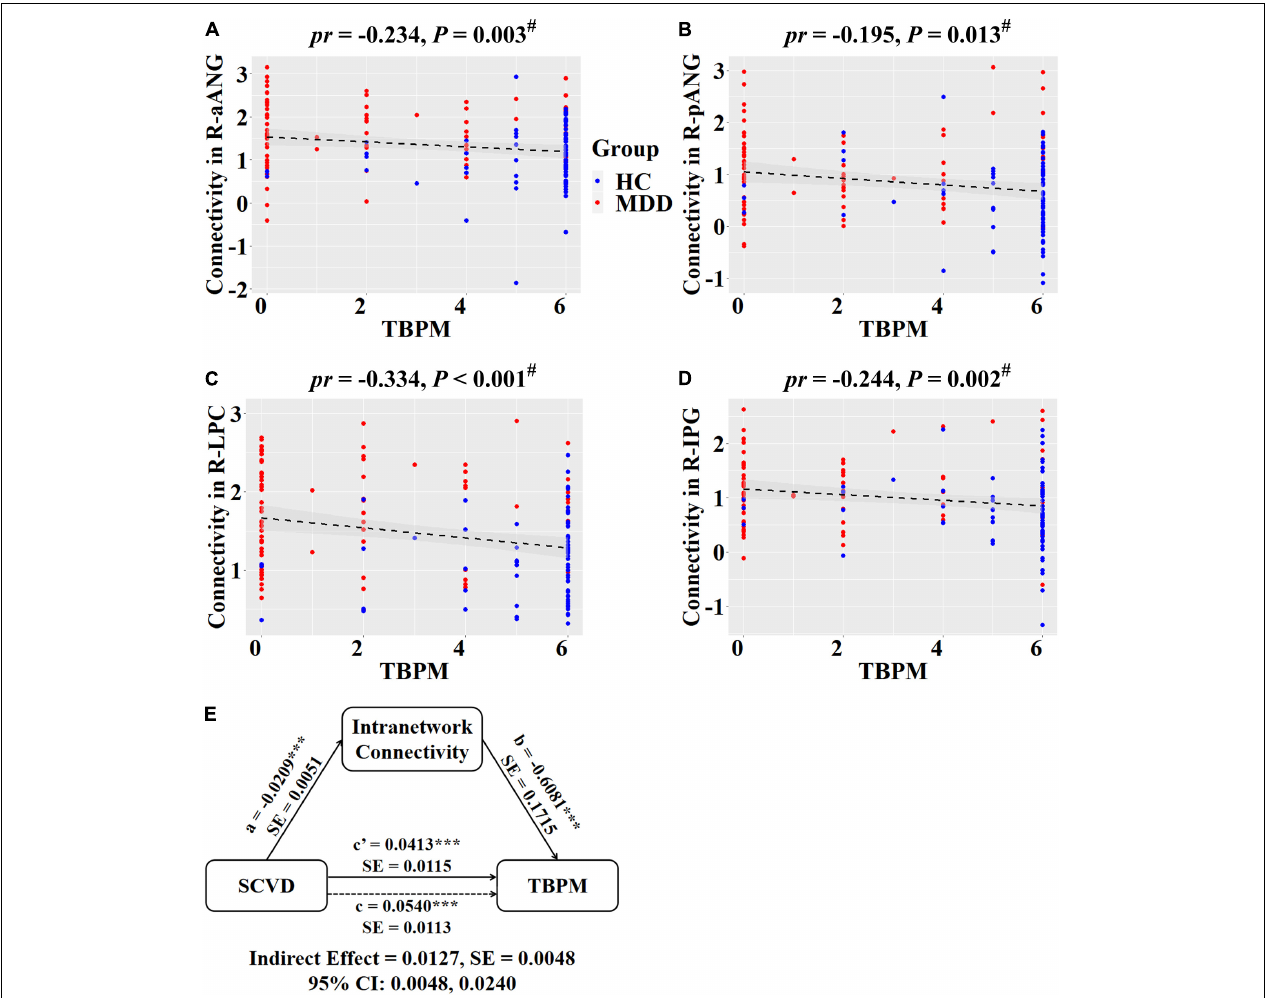
FIGURE 5 | Associations between SCVD, intranetwork functional connectivity, and TBPM in females. (A–D) Scatter plots show correlations between SCVD-related intranetwork connectivity and TBPM. (E) Graphical representation of the mediation analysis between SCVD and TBPM with first intranetwork functional connectivity component as the mediator: estimates of the mediated ( a × b ), direct ( c (cid:48) ), and total ( c ) effects. # P < 0.05, false discovery rate correction for multiple comparisons. *** P < 0.001. SCVD, serum concentration of vitamin D; TBPM, time-based prospective memory; aANG, anterior angular gyrus; pANG, posterior angular gyrus; LPC, lateral parietal cortex; IPG, inferior parietal gyrus; HC, healthy controls; MDD, major depressive disorder; R, right; pr , partial correlation coefficient; SE, standard error; CI, confidence